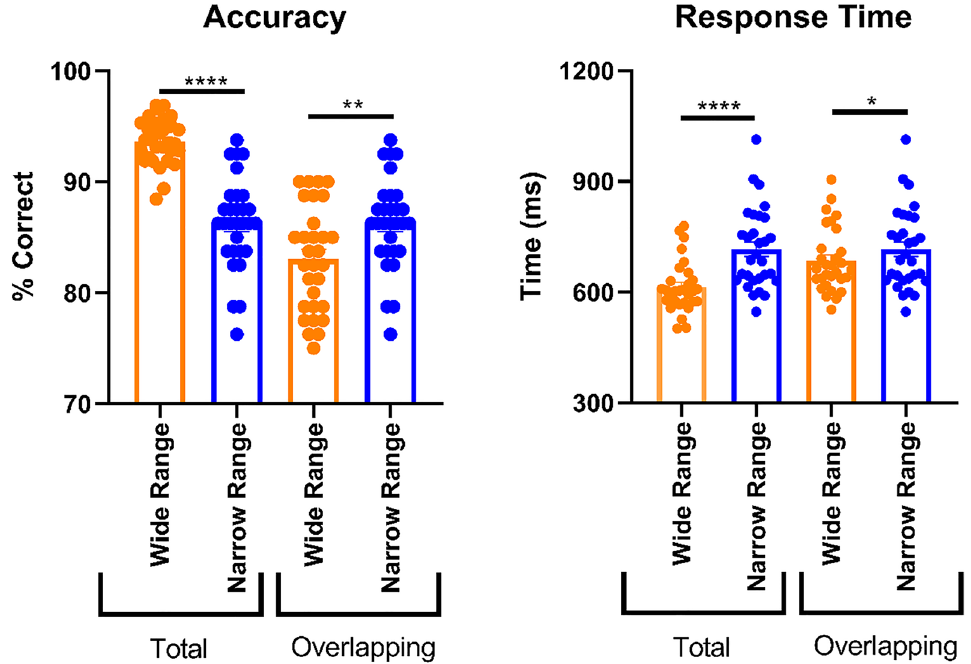
Figure 4. Accuracy and response times from Experiment 2. Conventions as for Experiment 1 (see Fig. 3). * = p < 0.05, ** = p < 0.01, **** = p <